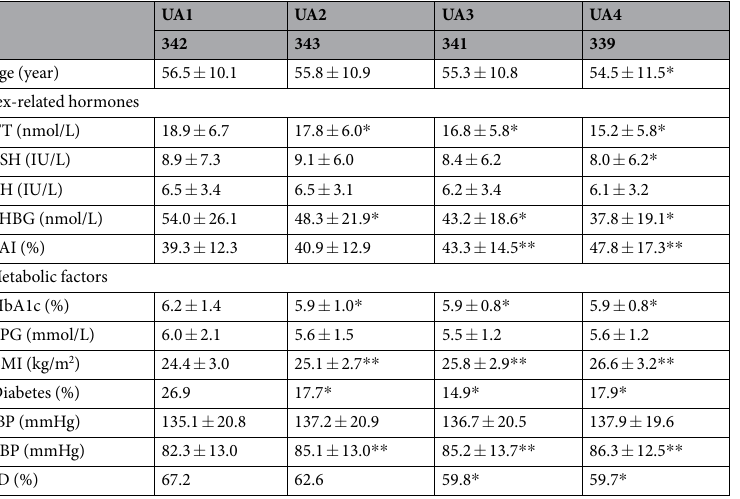
Table 2. Characteristics of the participants by quartiles of UA. The quartile ranges of UA were ≤ 289 μ mol/L (UA1), 290–341 μ mol/L (UA2), 342–396 μ mol/L (UA3) and ≥ 397 μ mol/L (UA4). The data were summarized as the mean ± standard deviation for continuous variables, or as number with proportion for categorical variables.